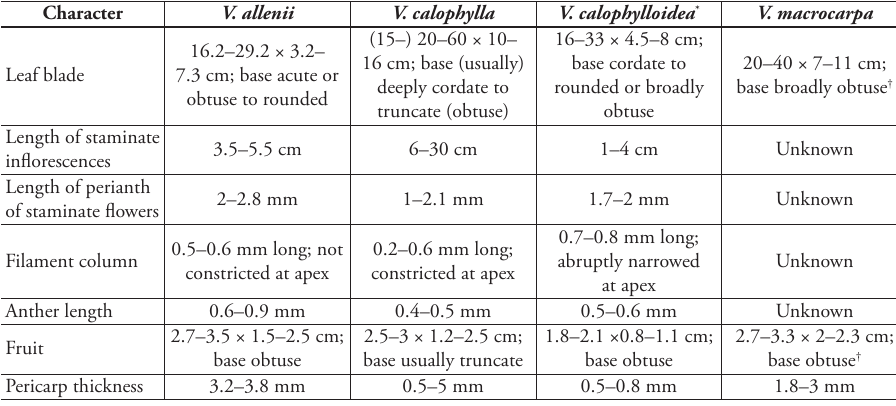
Table 2. Comparison of Virola allenii with the morphologically most similar species.